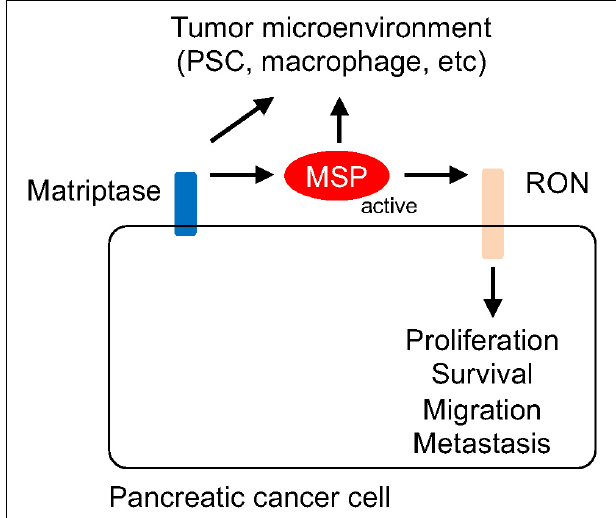
FIGURE 6 | Schematic representation of the mechanism by which the matriptase-MSP-RON signaling axis modulates pancreatic cancer progression. Matriptase mediates maturation and activation of MSP, which in turn stimulates RON-modulated signaling events. It is conceivable that Matriptase and MSP may also contribute to remodeling of the tumor microenvironment, through regulating the functions of the stellate cell, the macrophage, or other immune